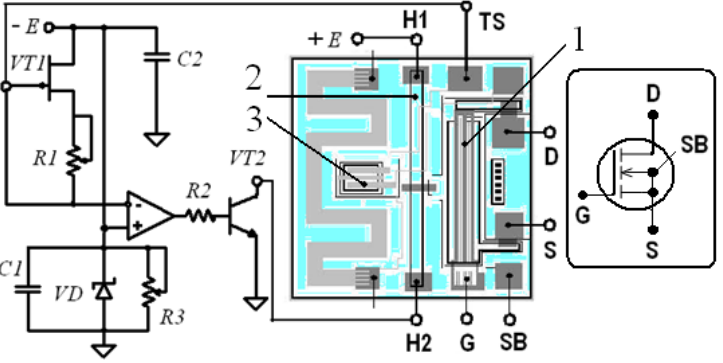
Figure 1. The temperature-stabilization circuitry, the sensor chip layout with output pads’ and